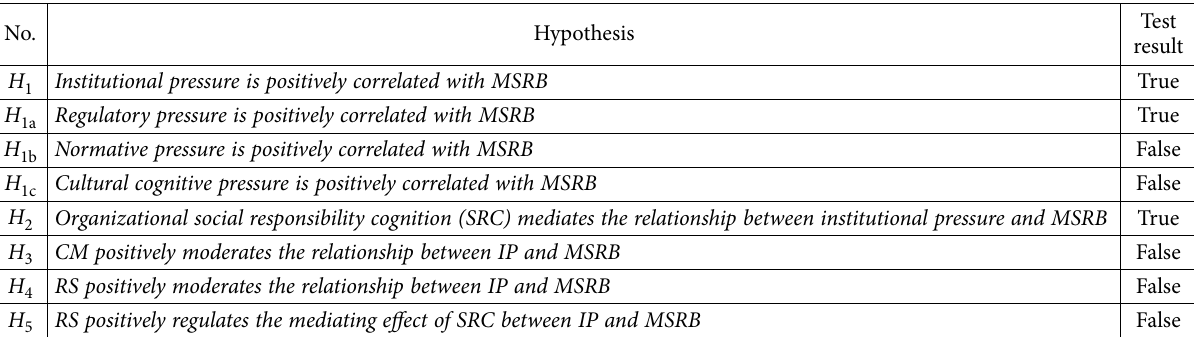
Table 11. Summary of research hypothesis test